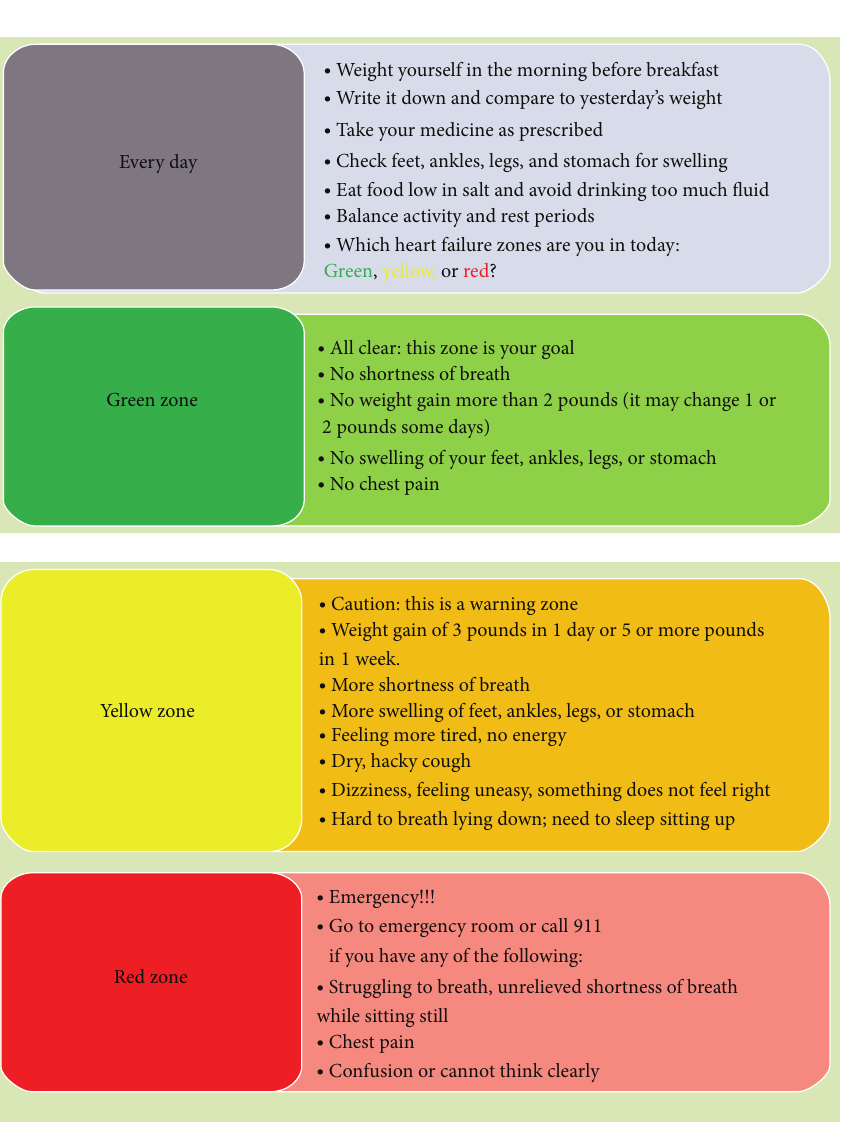
Figure 2: Heart failure